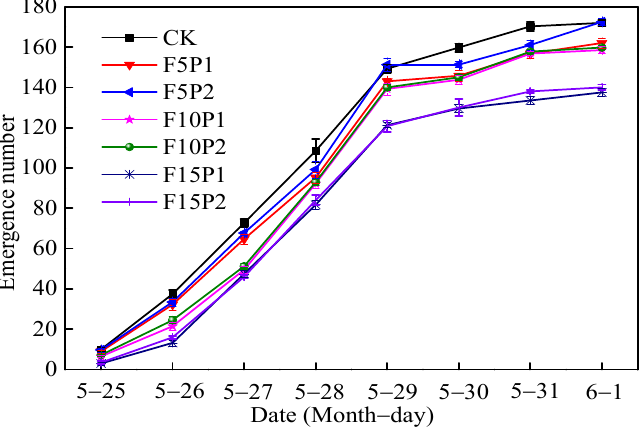
Figure 1. The daily emergence number of Artemisia ordosica in consolidated soil layer (CSL).